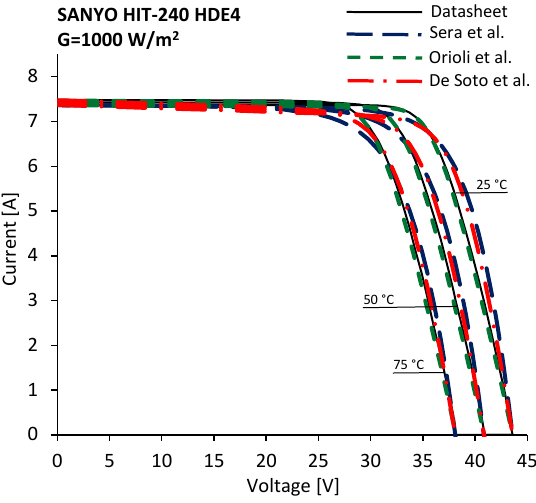
Figure 13. Comparison between the issued I-V characteristics of Sanyo HIT-240 HDE4 at G = 1000 W/m 2 and the characteristics calculated by means of the Sera et al ., the Orioli et al . and the De Soto et al . models.